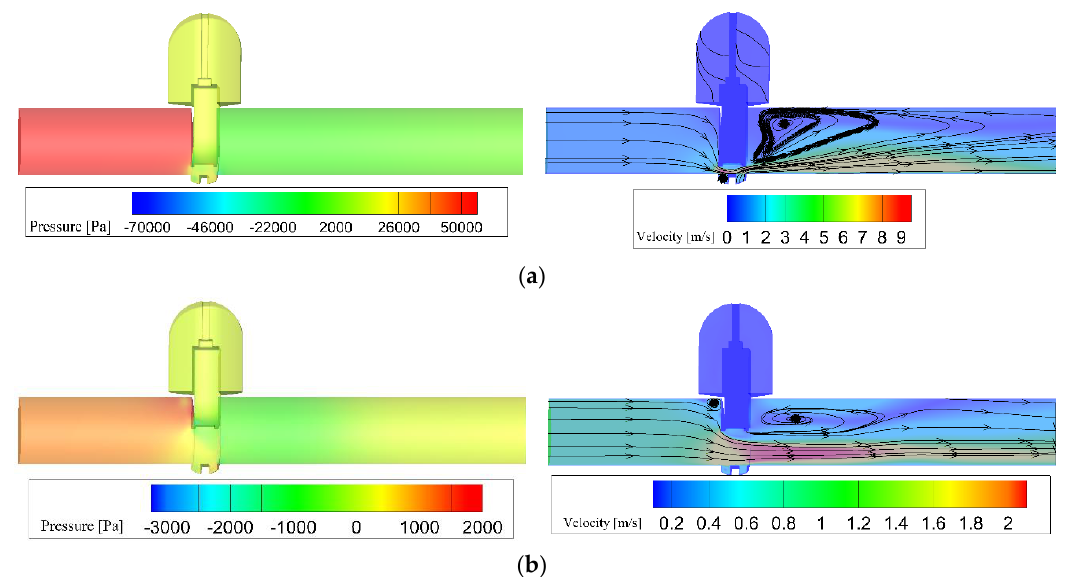
Figure 9. Pressure and flow fields under different valve opening degrees: ( a ) 20% opening; and, ( b ) 60% opening.